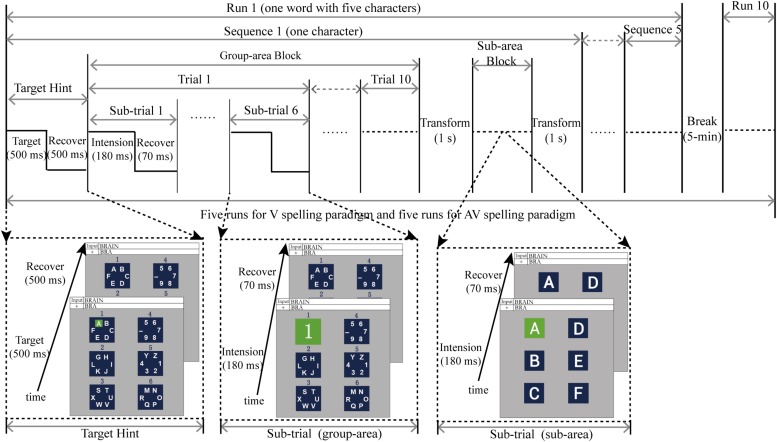
Time course of the experiment.